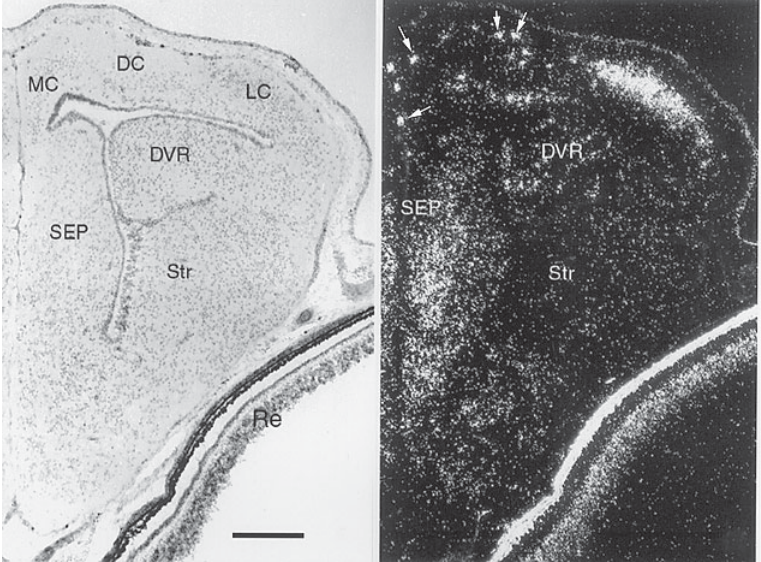
Figure 5. Reelin mRNA expression in the lizard embryonic cortex. Bright and dark field view of a coronal section through a lizard embryo ( Lacerta viridis ). In situ hybridization with a [ 33 P]-labeled, species-specific reelin riboprobe. The elaborate radial organization of the cortical plate in the medial (MC) and dorsal cortex (DC), and the looser architectonics of the lateral cortex (LC) are evident. Reelin-positive cells are heavily labeled in the marginal zone (arrows) and in the subcortex (not shown). DVR: dorsal ventricular ridge; SEP: septum; Str: striatum; Re: retina. Adapted from Ref. 18. Magnification bar: 200